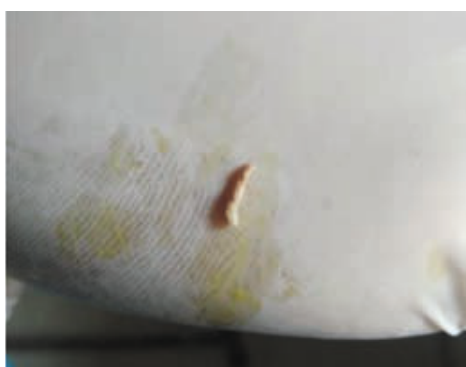
Ultrasonographic image showing distended bladder with echogenic